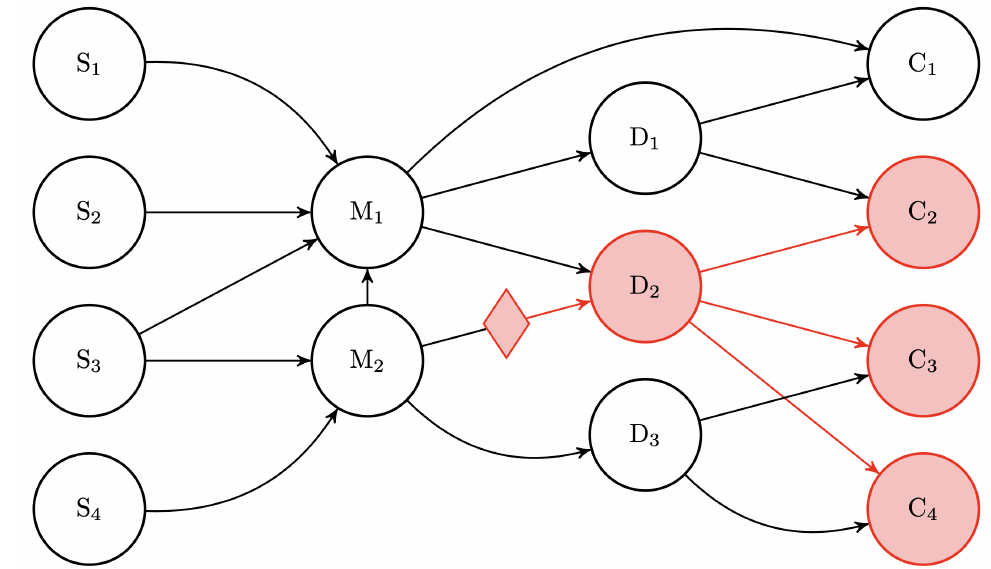
Figure 2. Directed acyclic graph of a supply chain network (SCN). A ripple effect occurs following a disruption (red diamond) between a manufacturer (M 2 ) and distributor (D 2 ), negatively affecting the distributor and three downstream customers (C 2 , C 3 , and C 4